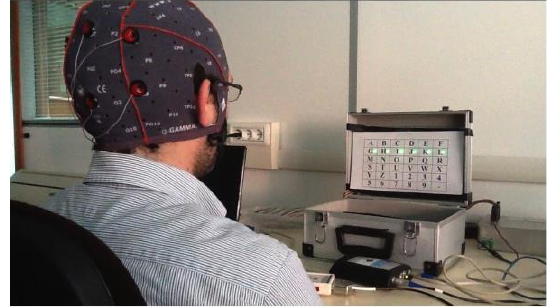
Figure 10. Experimental